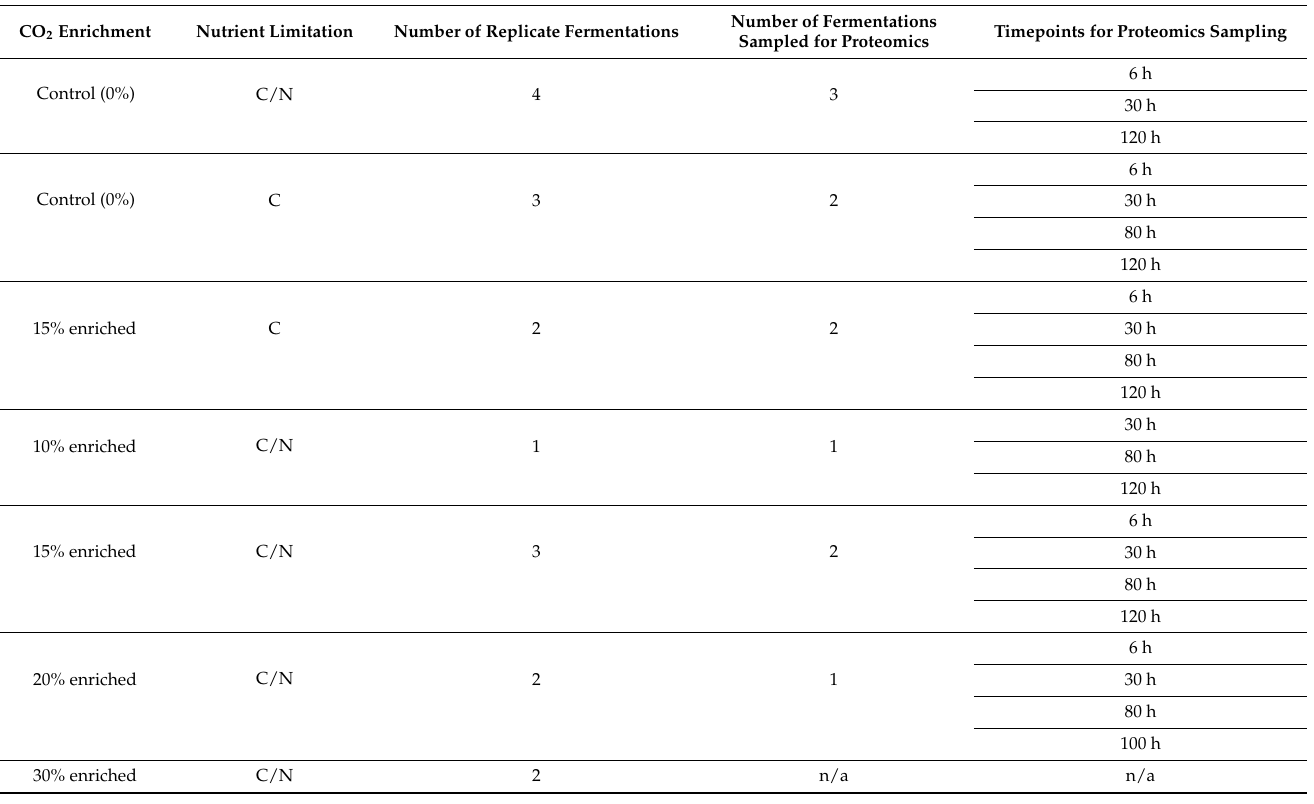
Table A1. Overview of the fermentations in the study. The number of replicate fermentations carried